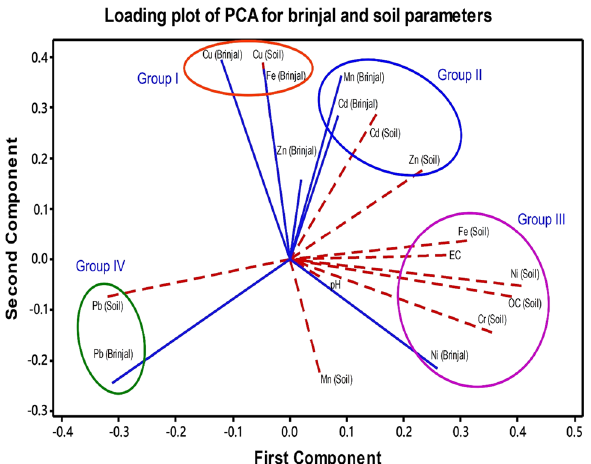
Figure 4. Loading plot presentation of the Principal Component Analysis (PCA) results showing the brinjal fruit (blue lines) and soil (dashed red lines) parameters. In the figure, the length of each eigenvector is proportional to the variance in the data for that variable. The angle between the eigenvectors represents the correlations among the different variables. The colored circle groups of variables indicated by I, II, III and IV show strong positive correlations with each